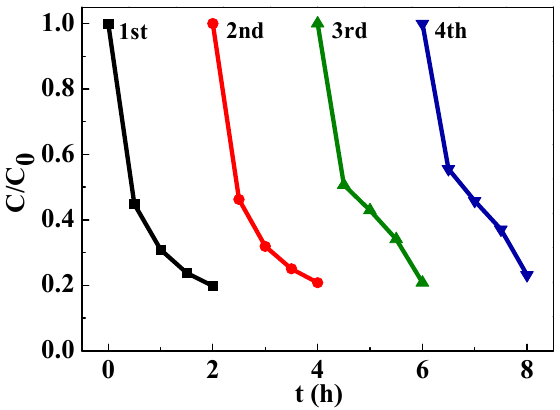
Figure 5. The cyclic degradation curves of the BaTiO 3 -TiO 2 core-shell heterostructures. The BaTiO 3 to TiO 2 ratio is 1.2:1.